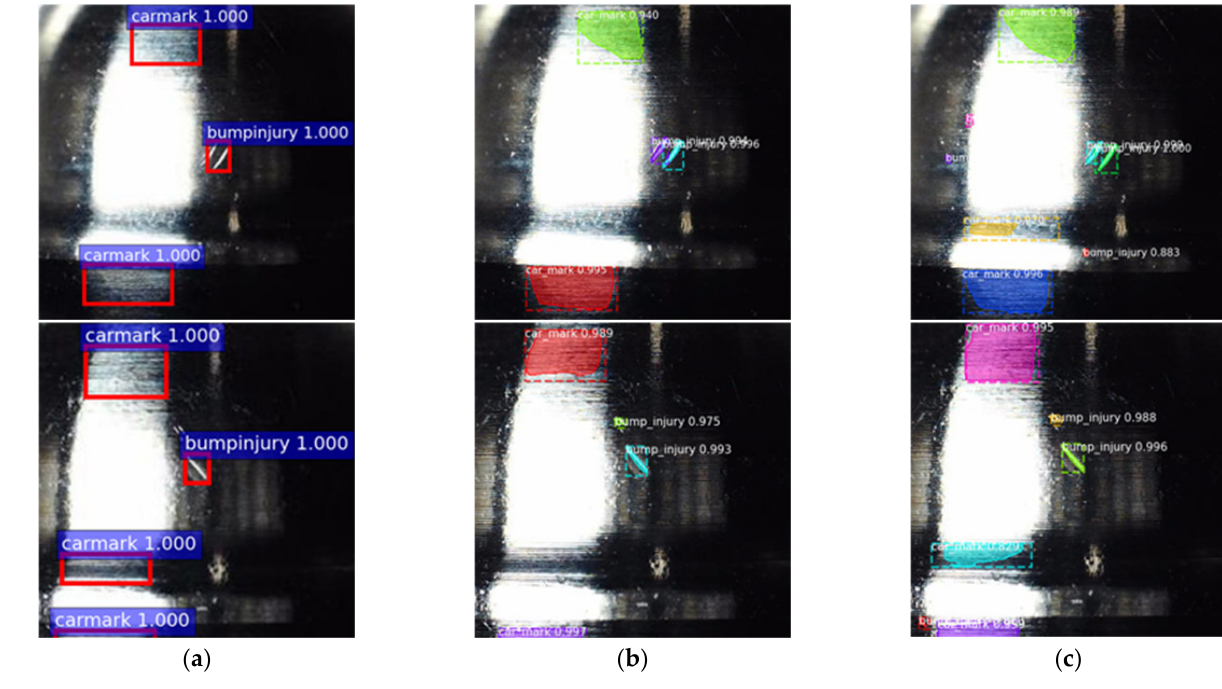
Figure 12. The comparison results of different methods: ( a ) Faster R-CNN; ( b ) Mask R-CNN; and ( c ) IA-Mask R-CNN.